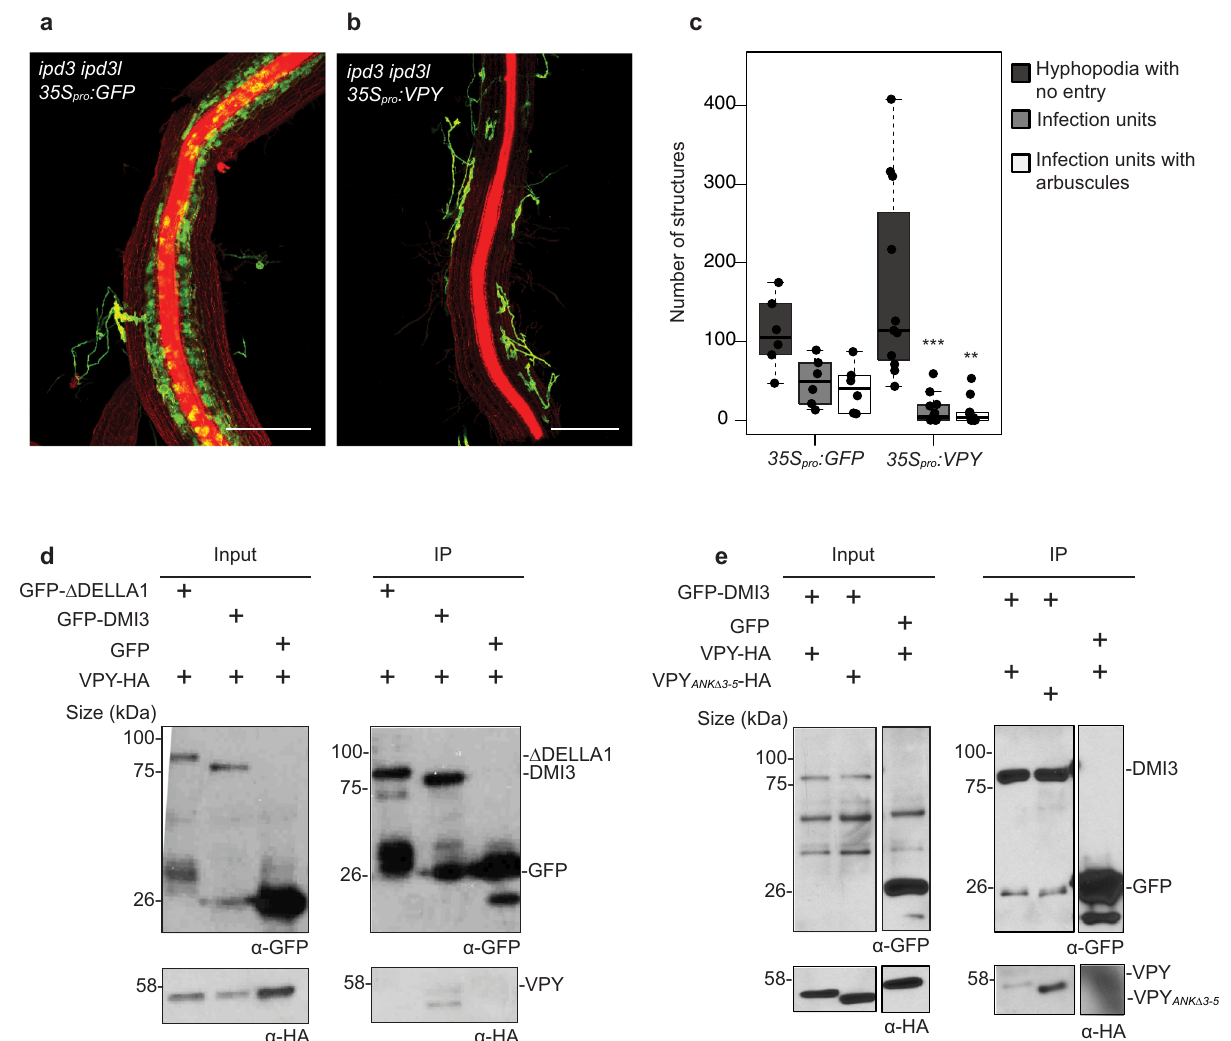
Fig.6|OverexpressionofVPYin ipd3ipd3l resultsina dmi3 -likephenotypeand VPY interactswith DMI3. a – c ipd3-2 ipd3l-2 roots transformed with 35Spro:VPY or a negative control, 35Spro:GFP , colonized with D. epigeae , and harvested three weeks post inoculation. Roots were stained with WGA-AlexaFluor488 (green) and propidiumiodide(red)torevealthefungusandplantcellwalls,respectively.Roots overexpressing VPY show hyphopodia that fail to enter the epidermis. Scale bar, 500 μ m. c Quanti fi cationofsurfacehyphopodia,infectionunits,andinfectionunits containing arbuscules in ipd3-2ipd3l-2 rootsoverexpressing 35Spro:GFP ( n =6root systems) and 35Spro:VPY ( n =11 root systems). ** indicates p <0.01, *** indicates p <0.001usingatwo-tailedStudent ’ s t test, 35Spro:VPY ascomparedto 35Spro:GFP